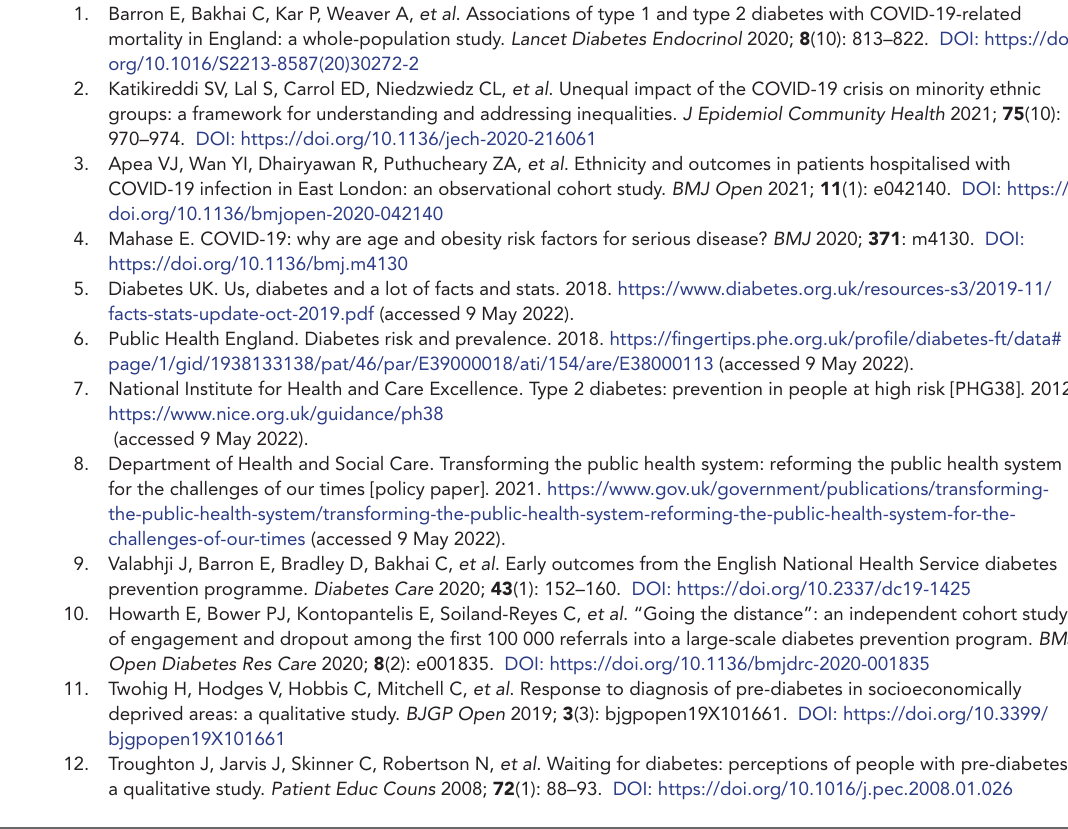
Barry E and Greenhalgh T. BJGP Open 2022; DOI: